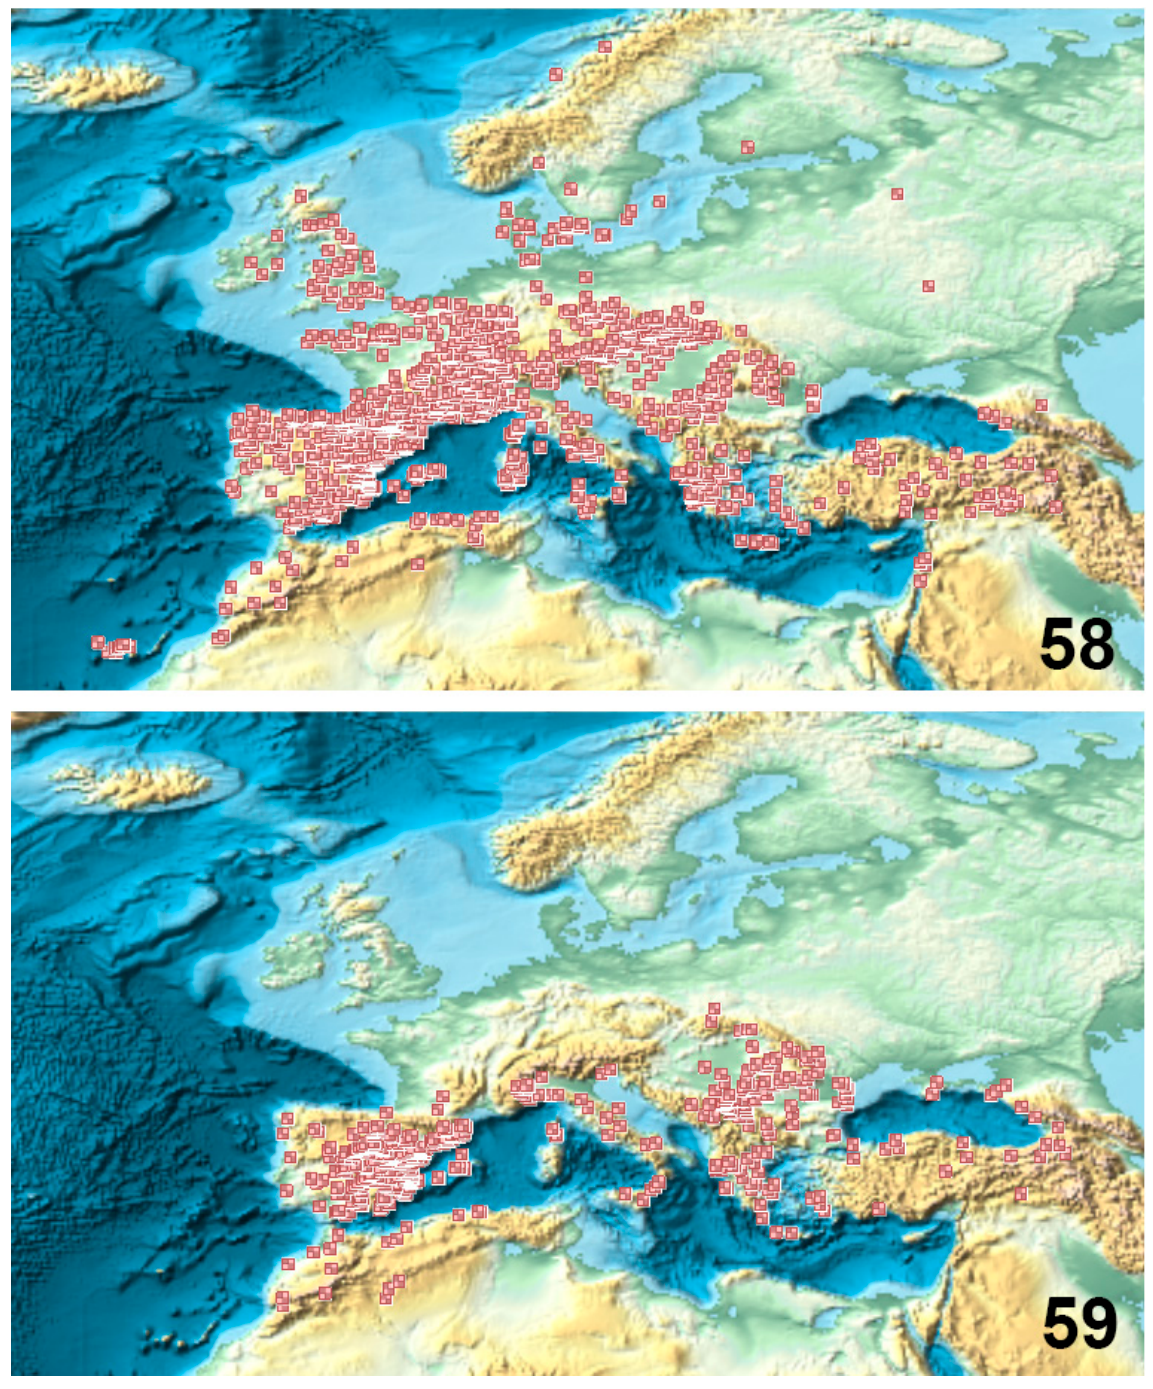
Figs 58–59. Distribution in the Euro-Mediterranean region, including Azores and Canaries. 58 . Subgenus Campodea s. str. Silvestri, 1932. 59 . Subgenus Dicampa Silvestri,